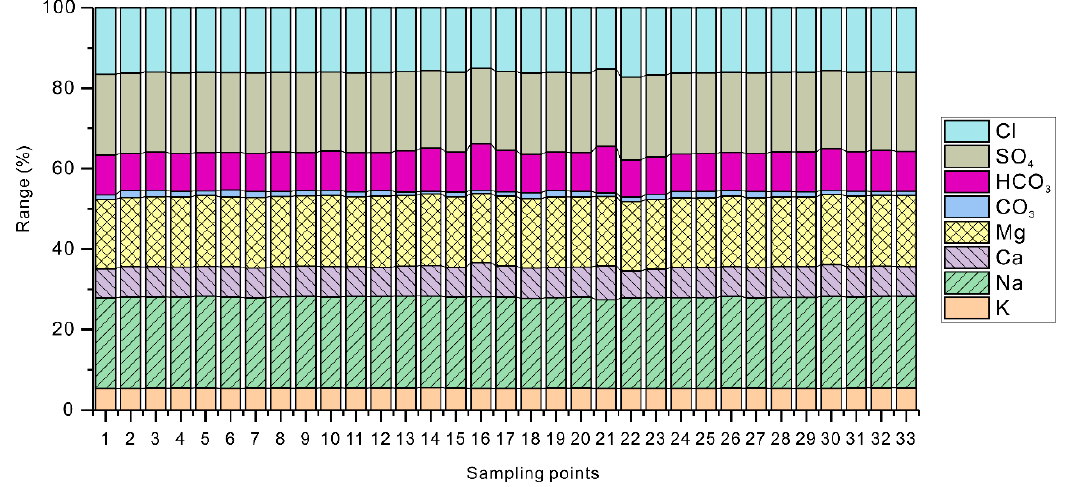
Figure 3. The percentage of equivalent weight of major ions in Bosten Lake waters at different sampling points.